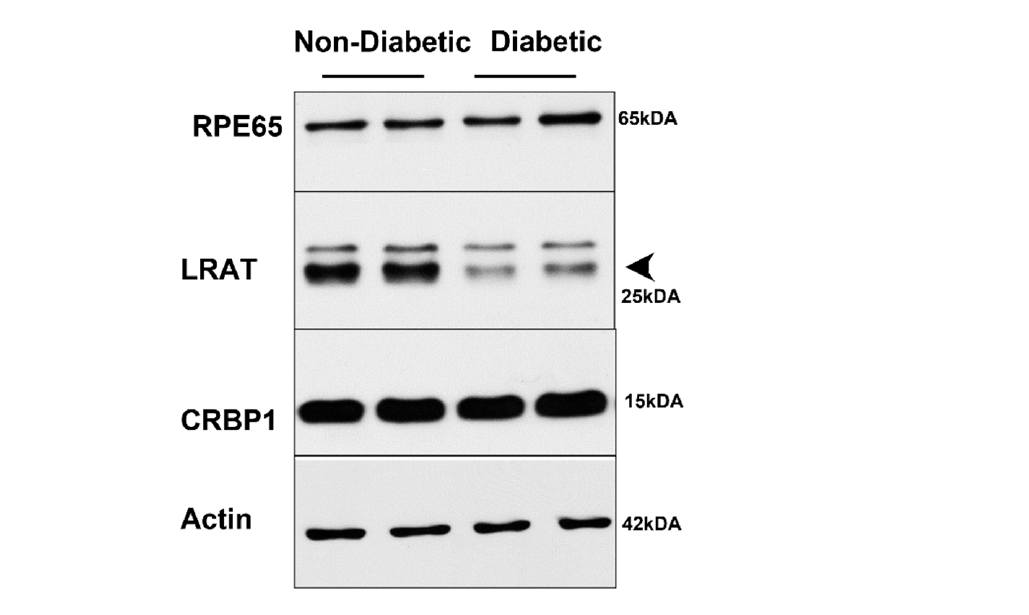
Figure 7. Western Blot analysis of visual cycle proteins in long-term diabetic WT mice . Protein extracts from eye cups (30 µg per lane) were separated on SDS PAGE and blotted on membranes as described in the materials and methods section. Representative blots are shown for RPE65, CRBP1, and LRAT proteins.